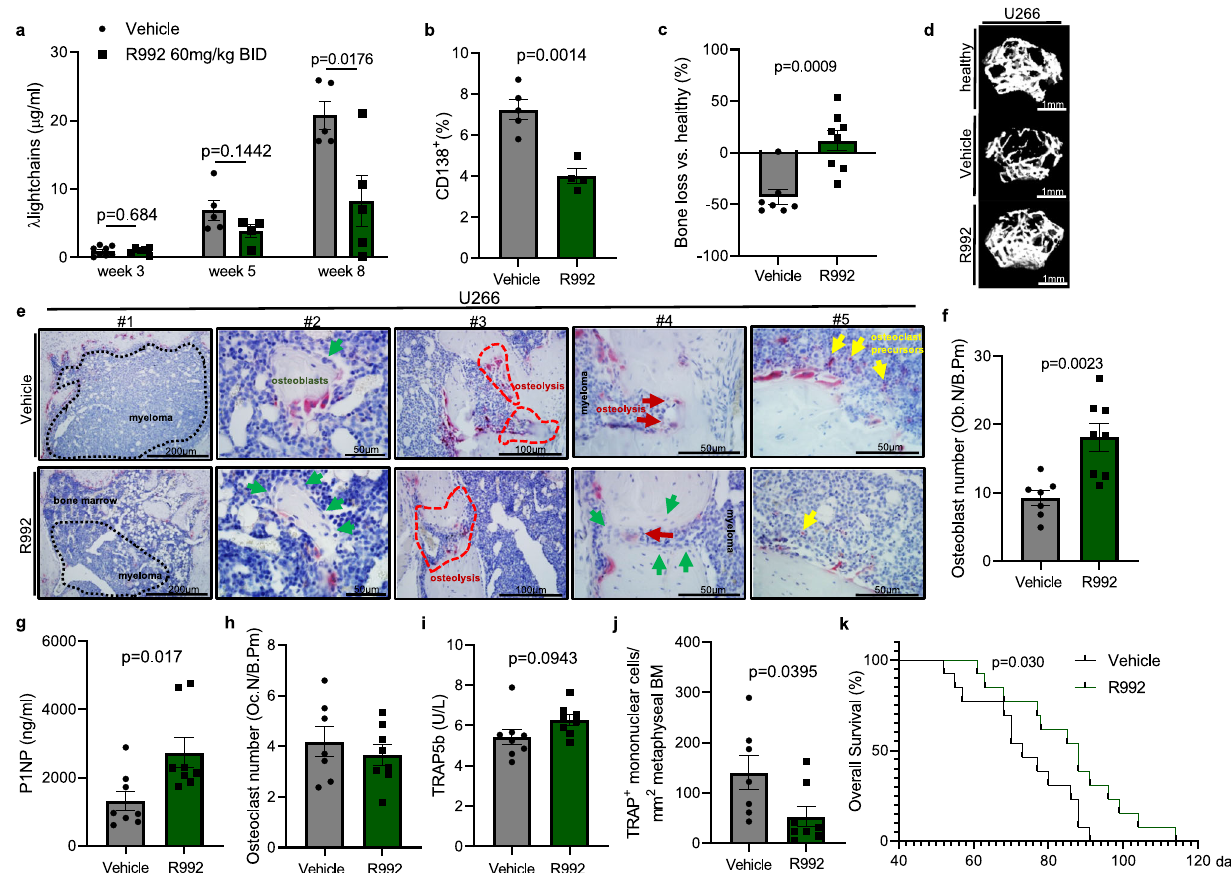
Fig. 5 | Pharmacologic MERTK blockade inhibits multiple myeloma tumor progression and bone disease. a – k After intraosseous femoral injection of U266 myeloma cell line, NSG mice were treated with vehicle or 60mg/kg R992 BID. a AssessmentofIg λ lightchainparaproteinintheperipheralbloodbyELISA(week3 n =8/6,week5 n =5/4,andweek8 n =5/5). b BonemarrowCD138 + myelomaplasma cellin fi ltrationinthecontralaterallegbyFACS( n =5/4). c μ CTanalysisofboneloss by calculating the change in bone volume (BV/TV) in relation to healthy control mice ( n =7/8). d 3D reconstructions of microcomputed tomography ( μ CT) recordings of the metaphyseal proximal region of the femur of healthy and myeloma-bearing mice. e Representative pictures of TRAP Hematoxylin staining (osteoclasts stained in red) showing myeloma in fi ltration in the bone marrow (#1), osteoblasts visible as cuboidal or polygonal mononuclear cells on the endosteal bone surface (arrows in green) (#2), osteolysis (#3), histologically detectable signs